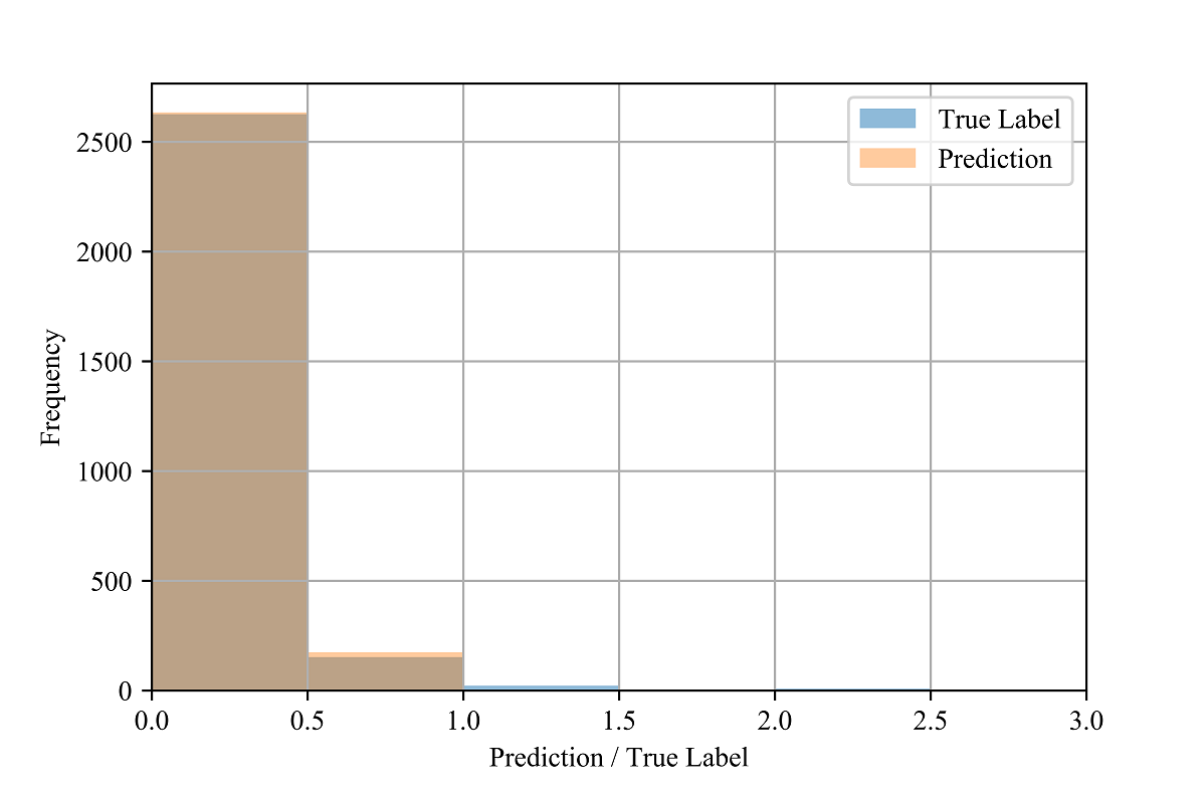
Figure 6. Distributions of the test labels (ie, true confirmed infection growth) and model predictions (n=2811) for the out-of-distribution